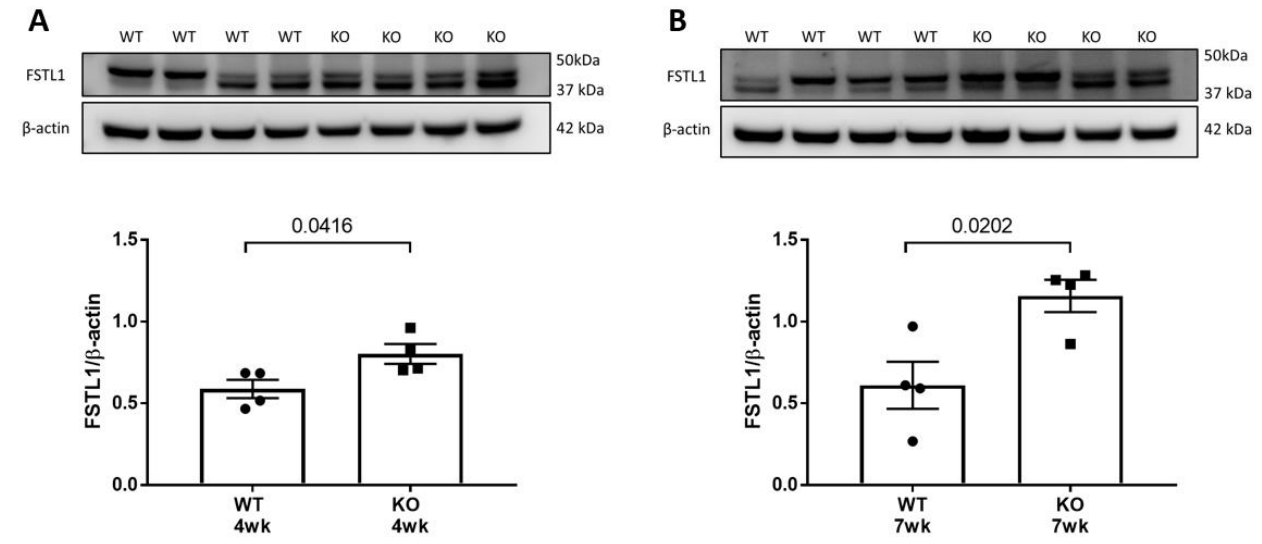
Figure 6. FSTL1 Protein Expression in WT and KO mouse kidney. ( A ) Representative immunoblot and quantification of FSTL1 in 4 week WT and KO mouse kidney. ( B ) Representative immunoblot and quantification of FSTL1 in 7 week WT and KO mouse kidney. Values are the mean ± SEM (black bars). p values were determined by Student’s t tests, and significance was defined as a p value < 0.05.